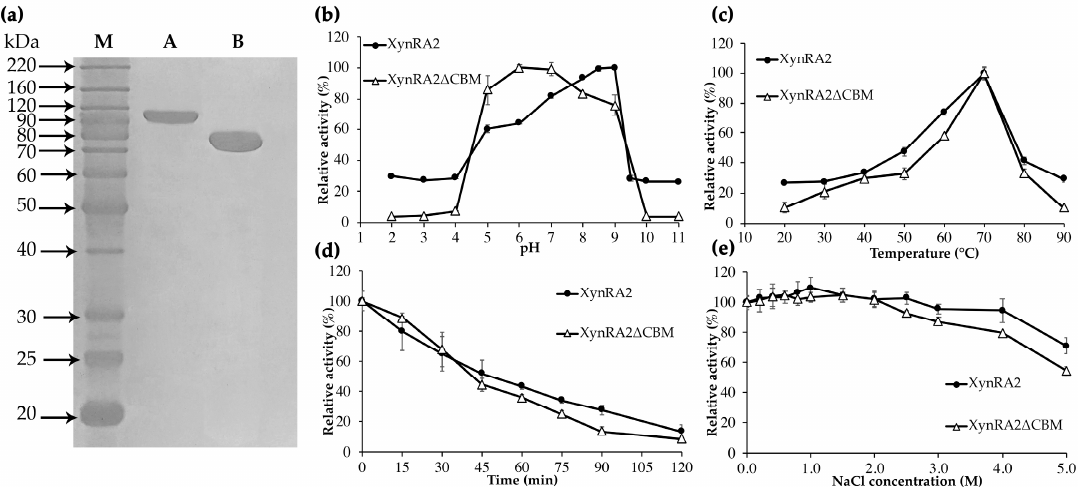
Figure 3. Molecular properties of purified XynRA2 and XynRA2 Δ CBM. ( a ) SDS-PAGE analysis of purified XynRA2 and XynRA2 Δ CBM. M , BenchMark ™ Protein Ladder; A , purified XynRA2; B , purified XynRA2 Δ CBM; ( b ) effect of pH in the range of 2 − 11; ( c ) effect of temperature from 20 − 90 °C; ( d ) thermostability at 70 °C across 120 min; ( e ) effect of NaCl from 0 − 5.0 M concentration.